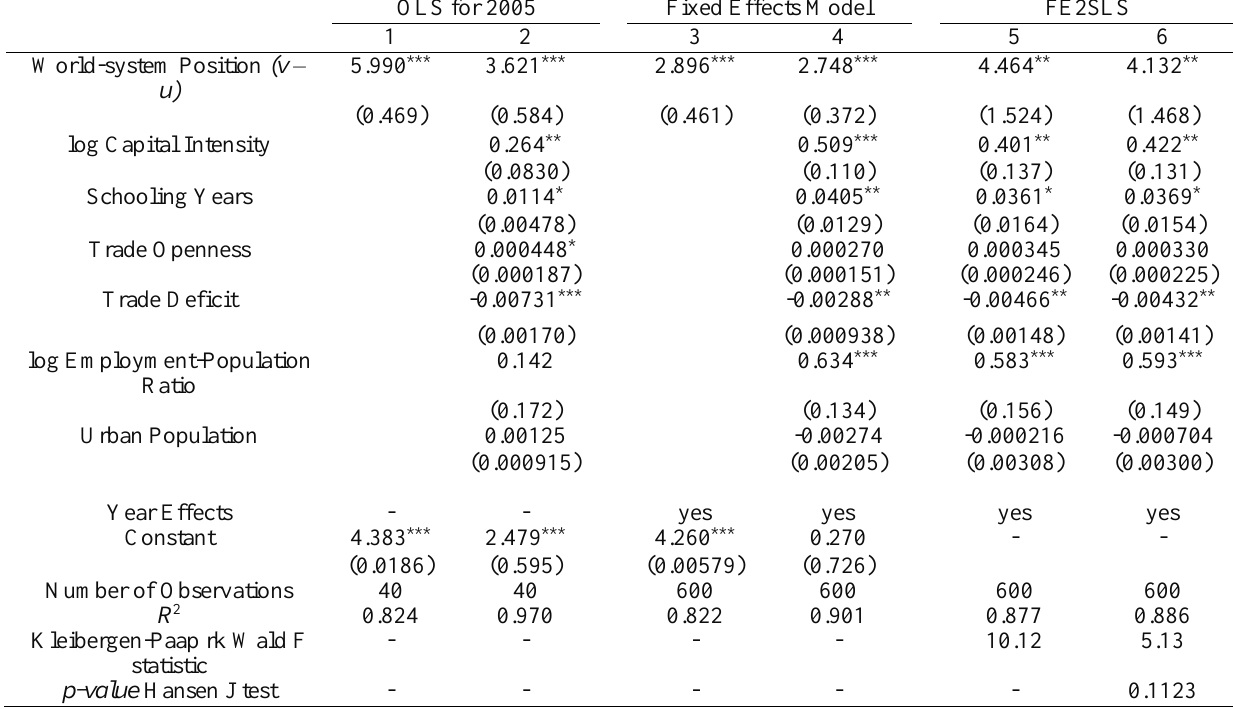
Table 5. Regressions of log GDP per capita (PPP) on select independent